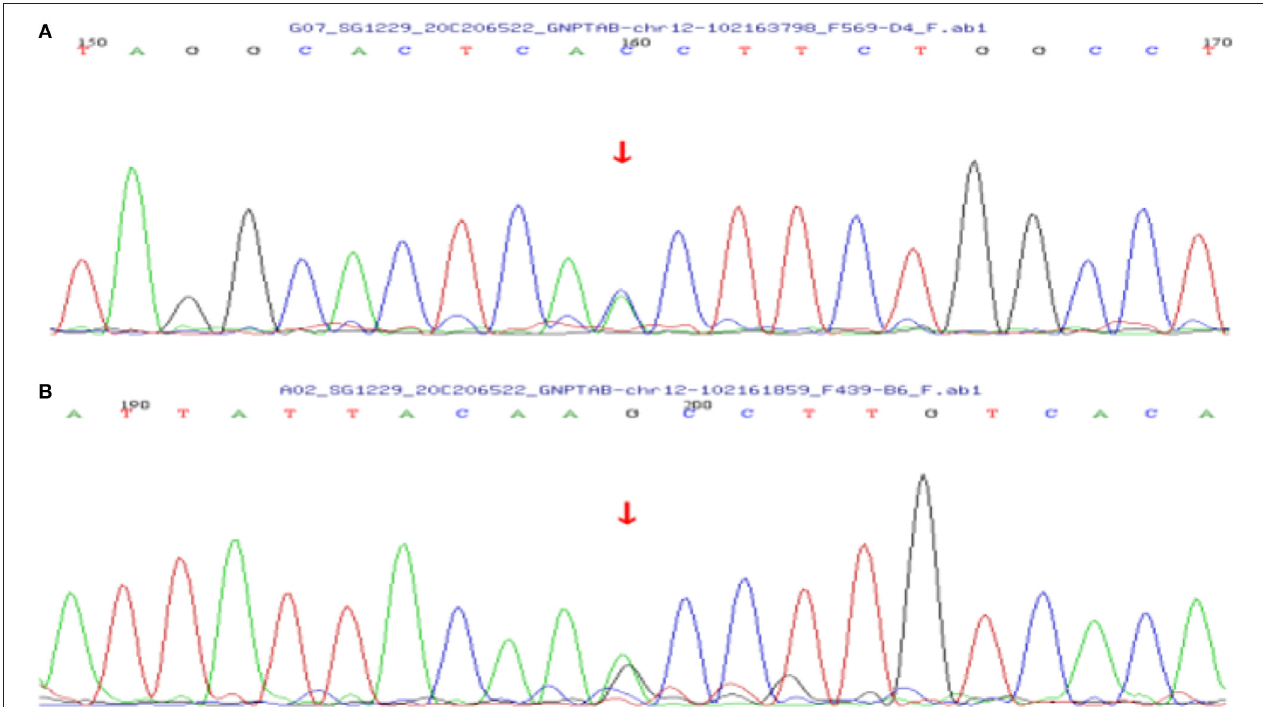
FIGURE 3 | Sanger sequencing chromatograms of the GNPTAB gene variants in case 1. (A) Heterozygous c.1284 + 1G > T variant inherited from the mother in the GNPTAB gene of the patient. (B) Heterozygous c.1364C > T variant inherited from the father in the GNPTAB gene of the patient.